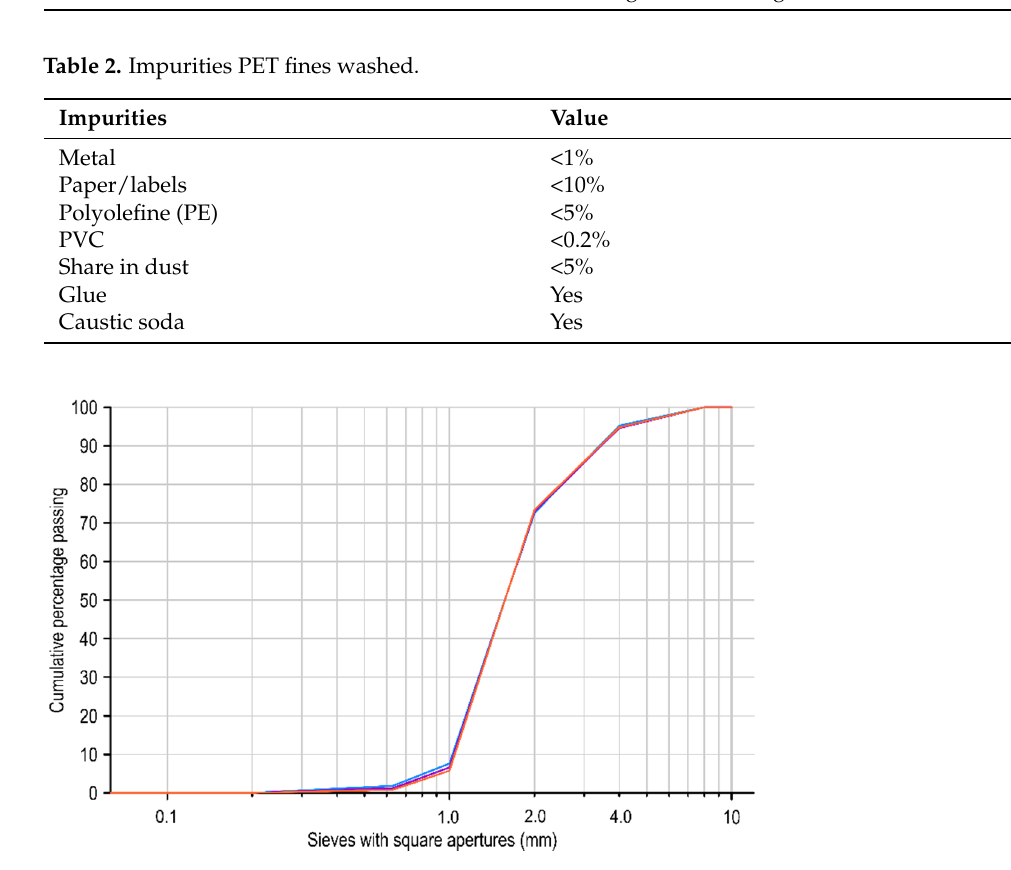
Table 1. Physical and mechanical characteristics of washed PET fines. Table 2. Impurities PET fines washed.